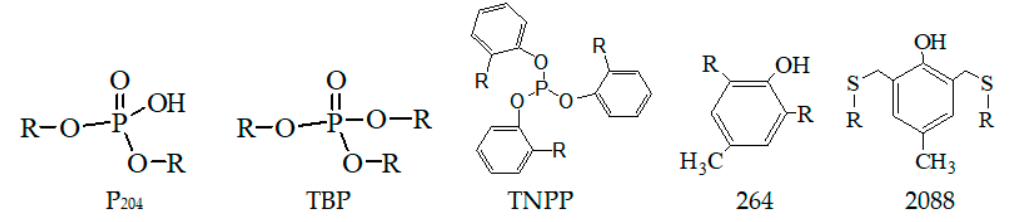
Figure 1. The structural formula of various ligands employed in this research.